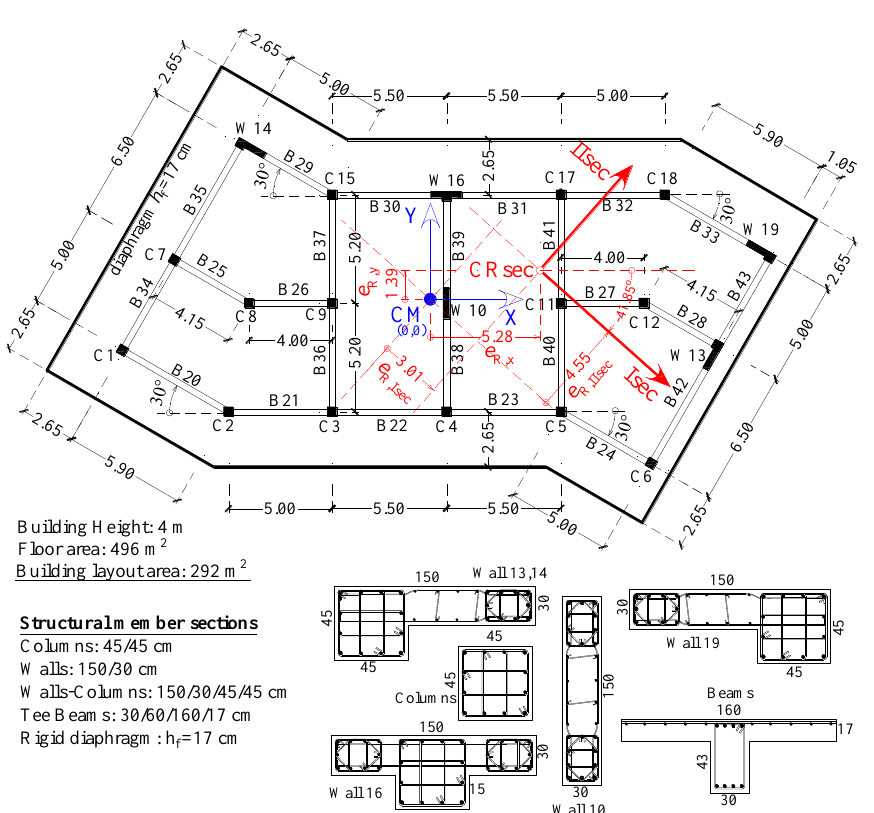
Fig. 5 . Up: floor plan of single-storey building, down: structural elements sections and reinforcement